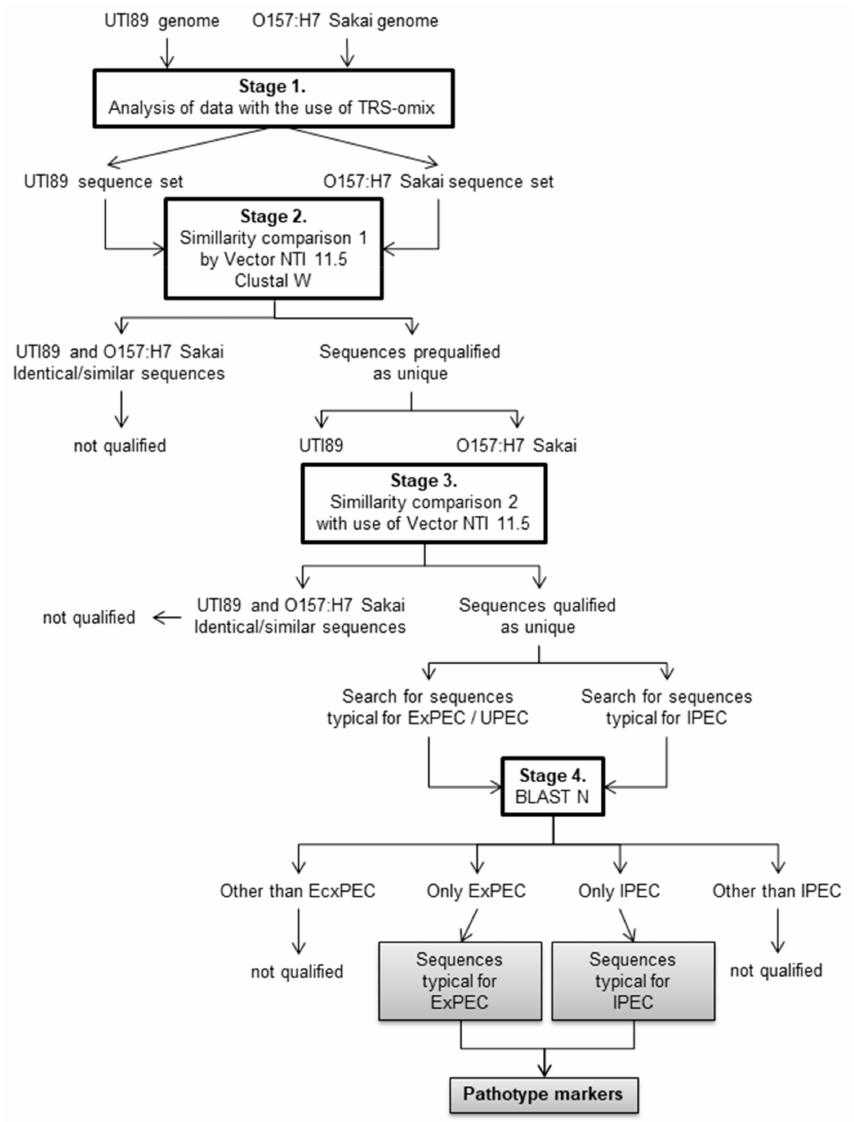
Figure 4. Scheme for analyzing two E. coli genomes resulting in filtering out DNA sequences specific only for the ExPEC pathotype or only for the IPEC pathotype (see details in the Results, Analysis of data with the use of TRS-omix and other IT tools